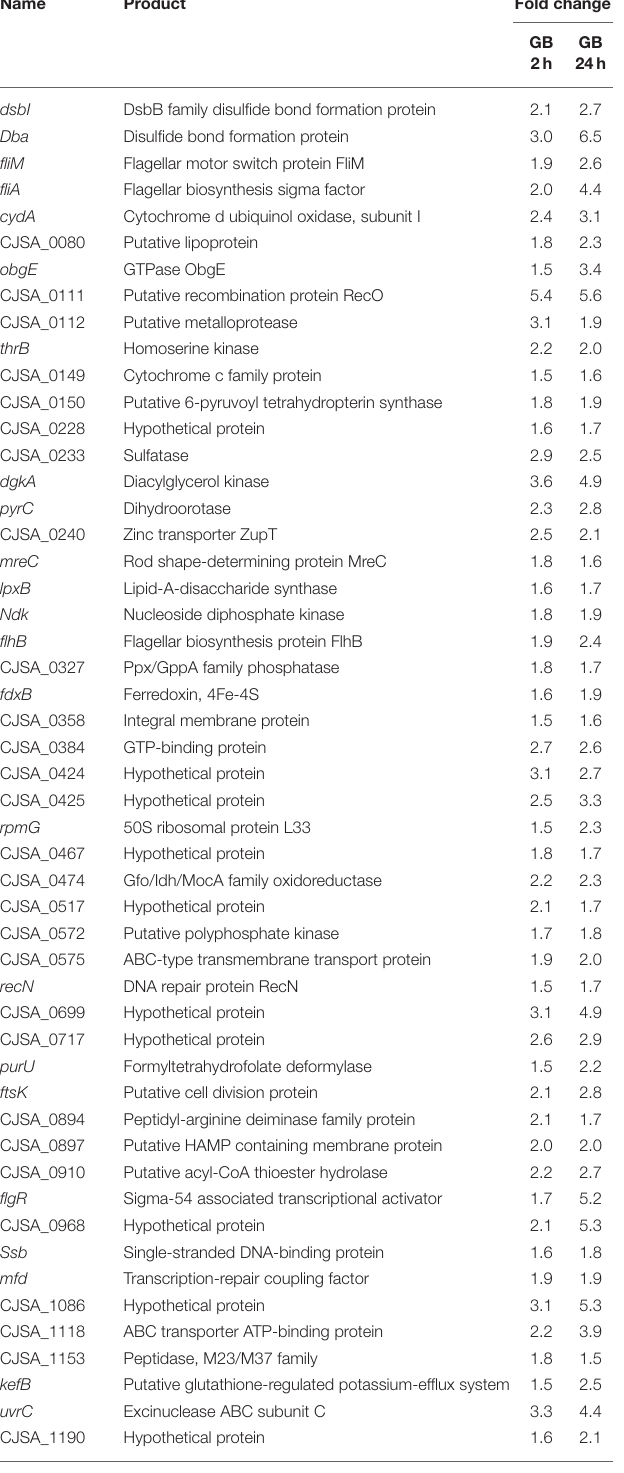
TABLE 3 | List of annotated genes identified to be upregulated only under the in vivo gallbladder 2h and gallbladder 24h conditions and not in bile alone at either timepoint when compared with the unexposed IA3902 inoculum; a comparison of fold change under each condition is